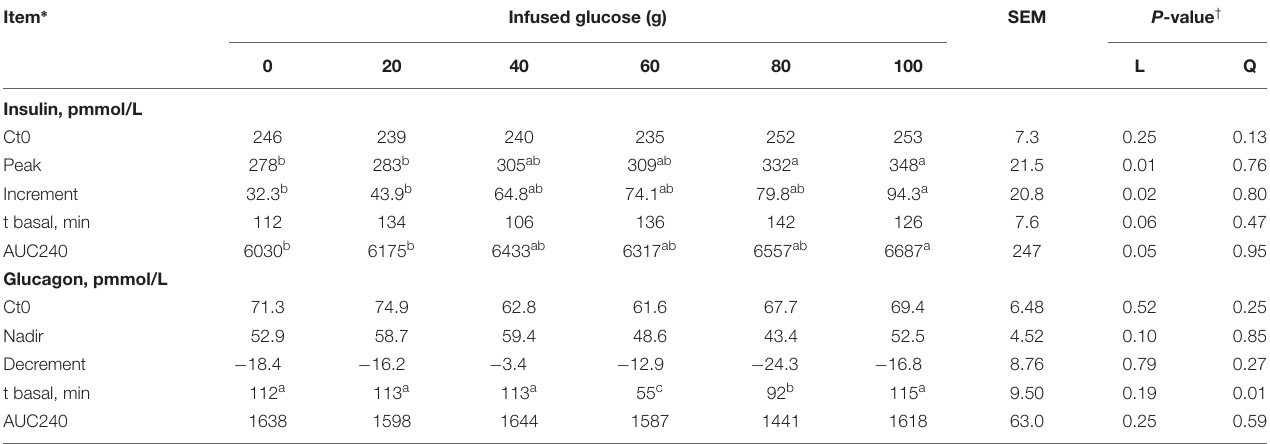
TABLE 6 | Time-course response indexes of blood insulin and glucagon to different doses of glucose infusion. Item ∗ Infused glucose (g)